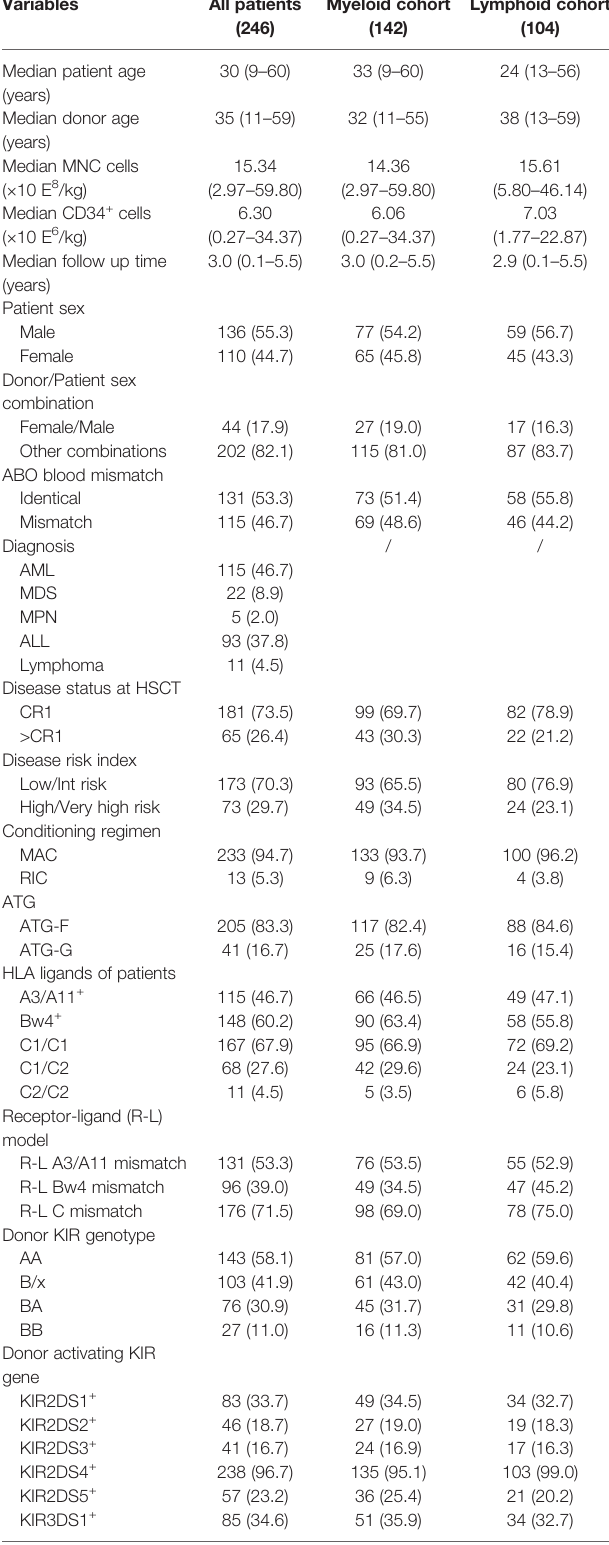
TABLE 1 | Clinical features of patients, donors, and transplants.